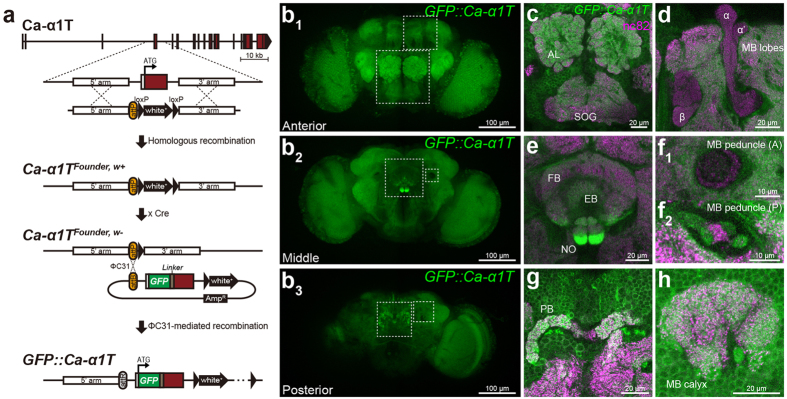
GFP::Ca-α1T expression in the adult brain.(a) Gene targeting and GFP::Ca-α1T generation strategy. Ca-α1T coding exons are red. (b) Adult brain expression of GFP::Ca-α1T (green) divided into maximal intensity projections of confocal stacks from the anterior (b1), middle (b2), and posterior (b3) brain. (c–h) GFP::Ca-α1T expression in specific neuropils whose location corresponds to the boxed areas in (b). (c) Expression in the antennal lobes (AL) and subesophageal ganglia (SOG). (d) Expression in the mushroom body (MB) lobes (α, β, and α’). (e) Expression in the fan-shaped body (FB), ellipsoid body (EB), and noduli (NO) of the central complex. (f) Expression in the (f1) anterior and (f2) posterior mushroom body (MB) peduncles. (g) Expression in the protocerebral bridge (PB) of the central complex. (h) Expression in the mushroom body (MB) calyx. Neuropils are counter-stained with the nc82 antibody (α-Bruchpilot, magenta).